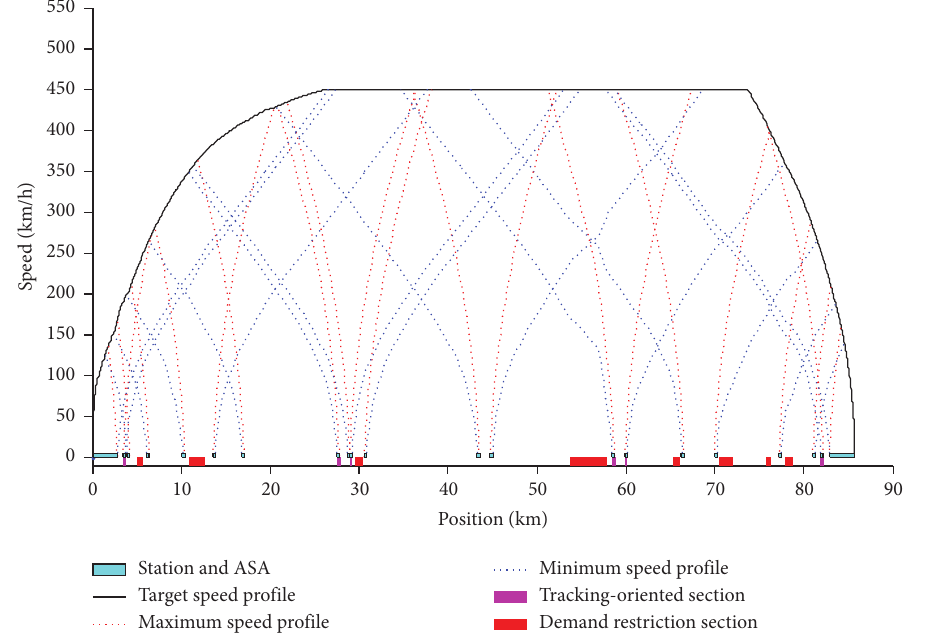
Figure 14: Layout scheme considering the two directions